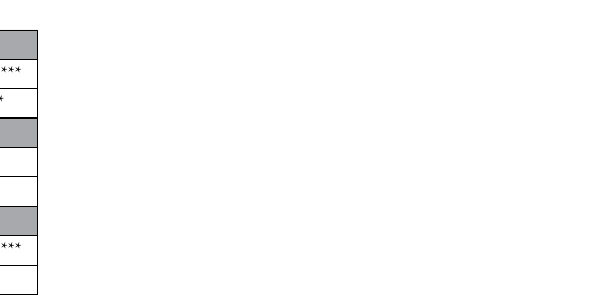
Figure 4. PLS-DA results for ( a ) Test 1 and ( b ) Test 2 with the comparison with workers restraining signals. Ellipses represent the 95% confidence region of occurrence of samples in one group. ( a ) plus and cross signs/ red lines: forward and backward chirps of queens; circles and triangles signs/blue lines: forward and backward chirps of males; overturned triangles and diamonds signs/green lines: forward and backward chirps of workers. ( b ) Circles signs/violet line: small honey drop chirp (2 μl); triangles signs/light green line: large honey drop chirp (20 μl); plus signs/dark green: restraining chirp.